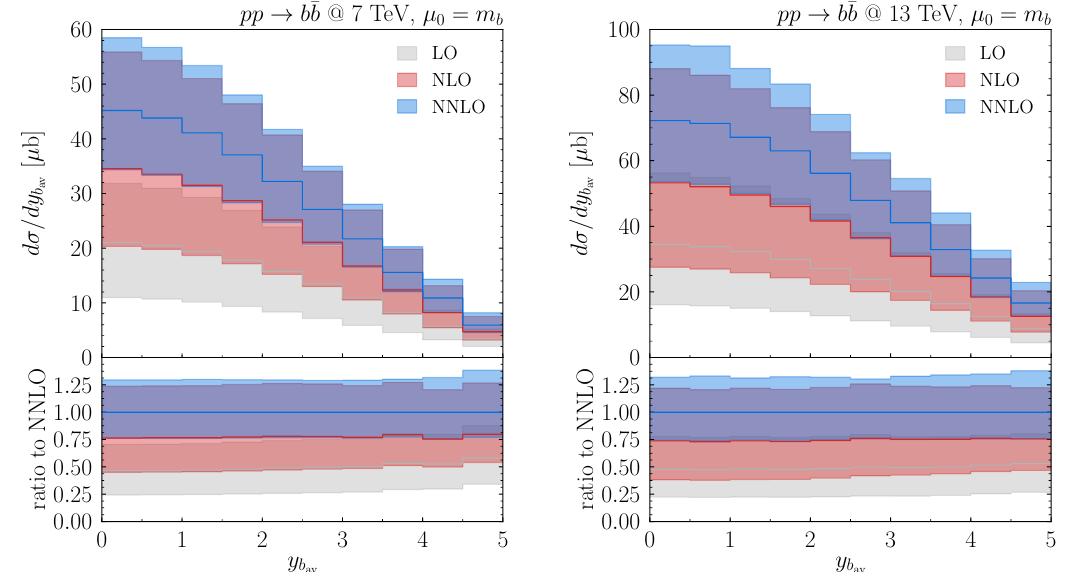
Figure 5 . Rapidity distribution of the bottom quark at the LHC for p s = 7 TeV (left) and 13 TeV (right). The lower panels show the ratio to the NNLO prediction.